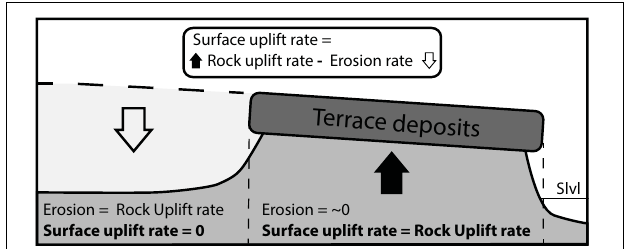
FIGURE 9 | Differential erosion of the marl-bedrock marine terraces and the implications for surface uplift rates. Slvl = sea level. Vertical scale exaggerated.